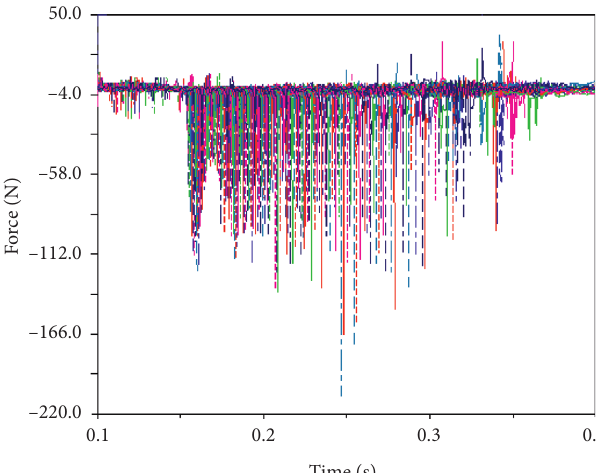
Figure 7: Collision forces between all rollers and cage at the stage of stop.